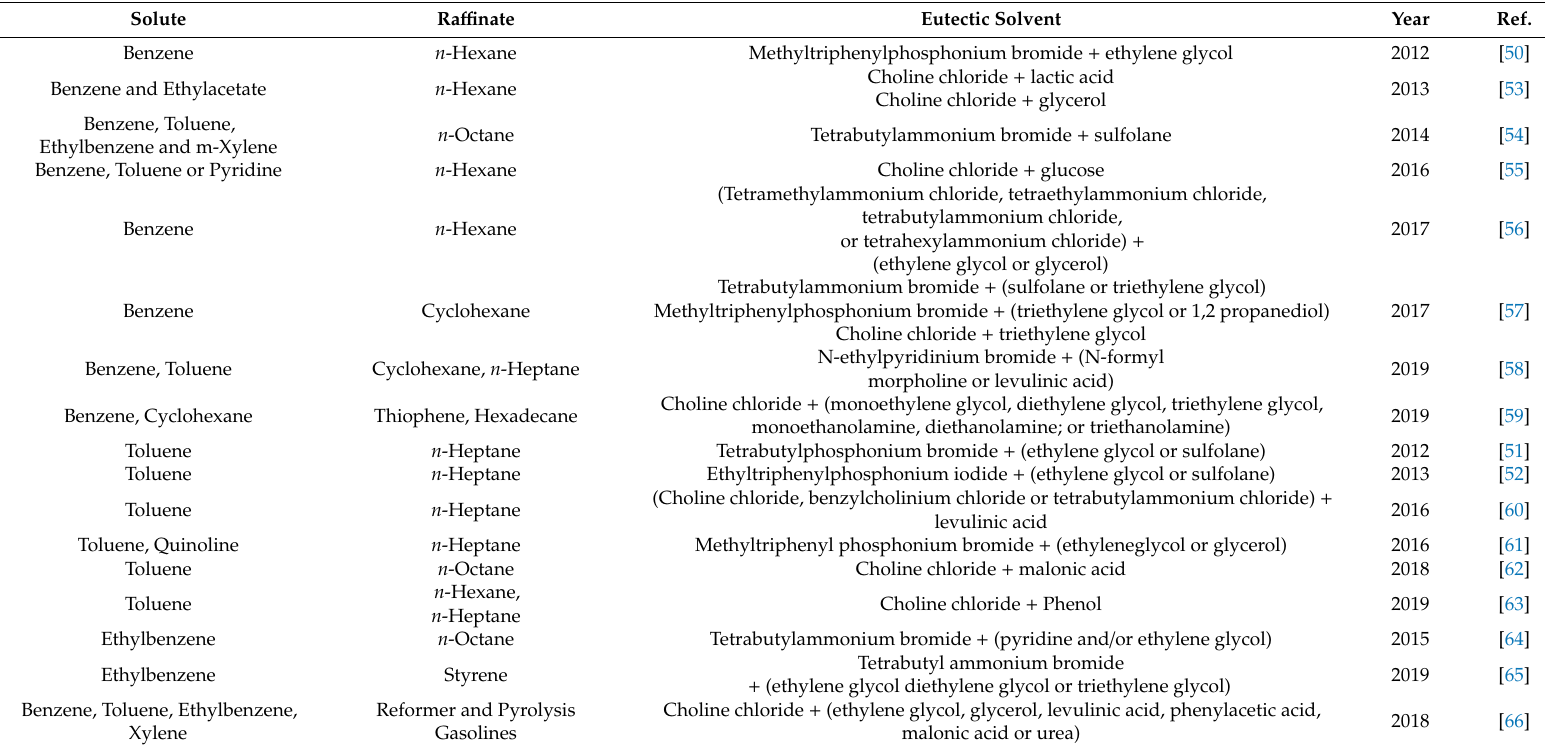
Table 2. Eutectic Solvents in the Liquid–liquid Extraction of Aromatic